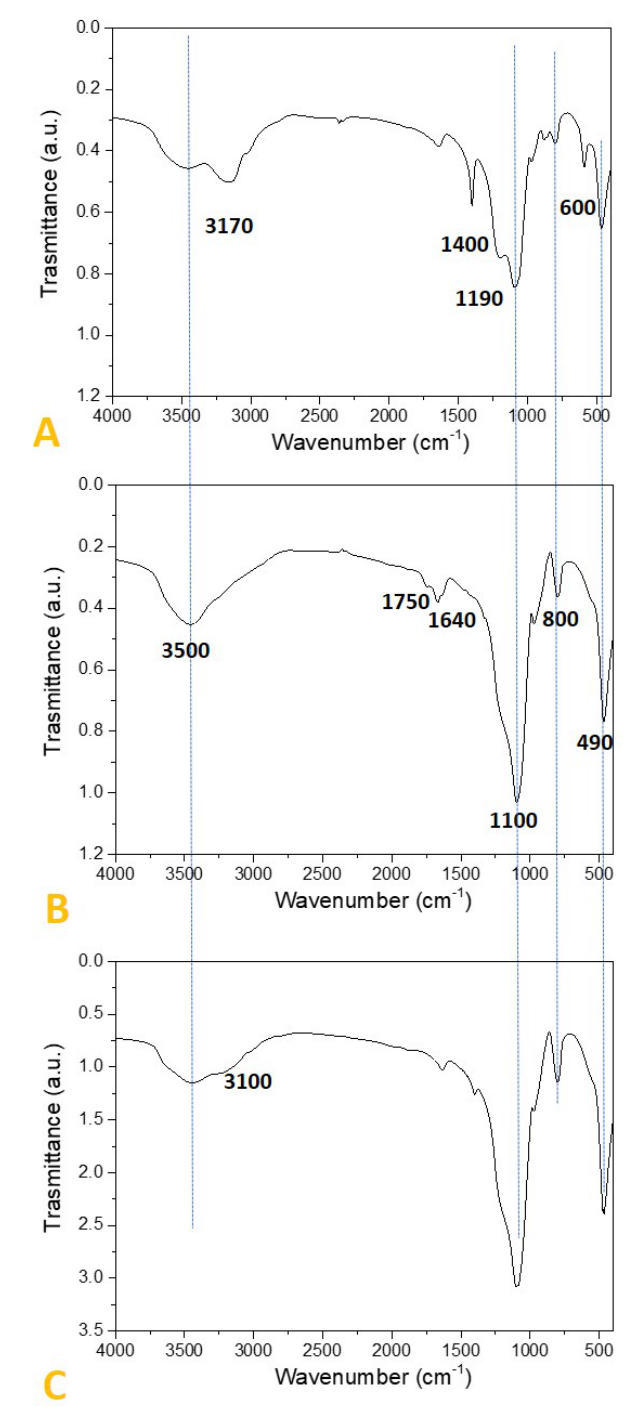
Figure 2. FTIR spectra of silica gel impregnated with ( A ) NH 4 HSO 4 , ( B ) HCl.Gly, and ( C ) NH 4 Br ammonium